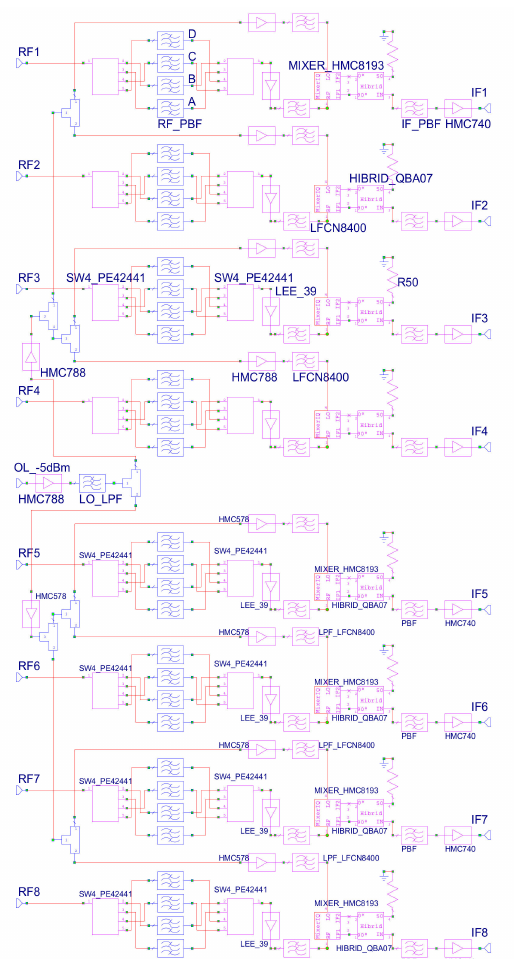
Figure 5. NI-AWR Microwave Office (version 14, National Instrument-Applied Wave Research, El Segundo, LA, USA, 2018) schematic of the eight-channel WS RF / IF receiver chain implemented on the PCB with models of the adopted commercial components: SP4T RF switches (Peregrine PE42441,